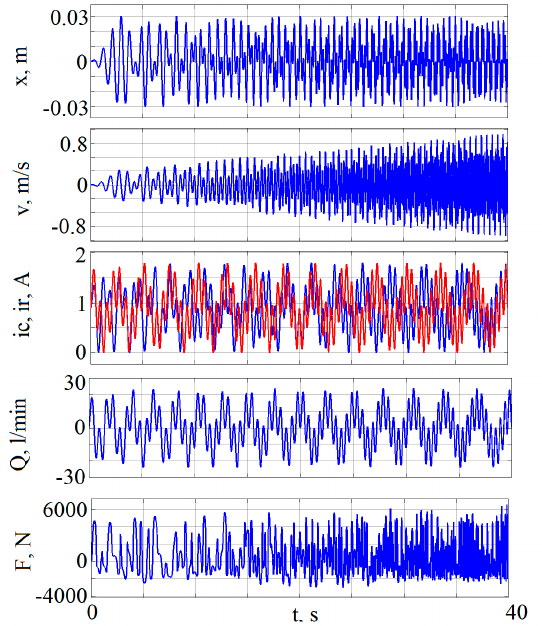
Figure 5. Training dataset.